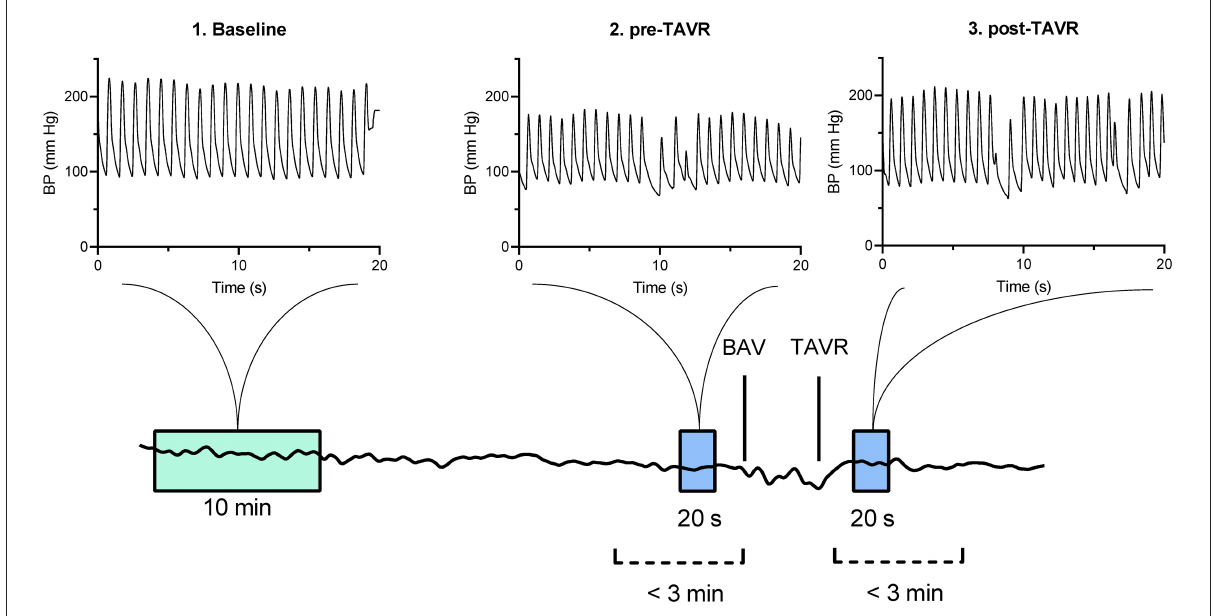
FIGURE1 Timeframe and measurement selection, visualized within a random patients’ total procedure waveform data. BAV, balloon aortic valvuloplasty; TAVI, Transcatheter Aortic Valve